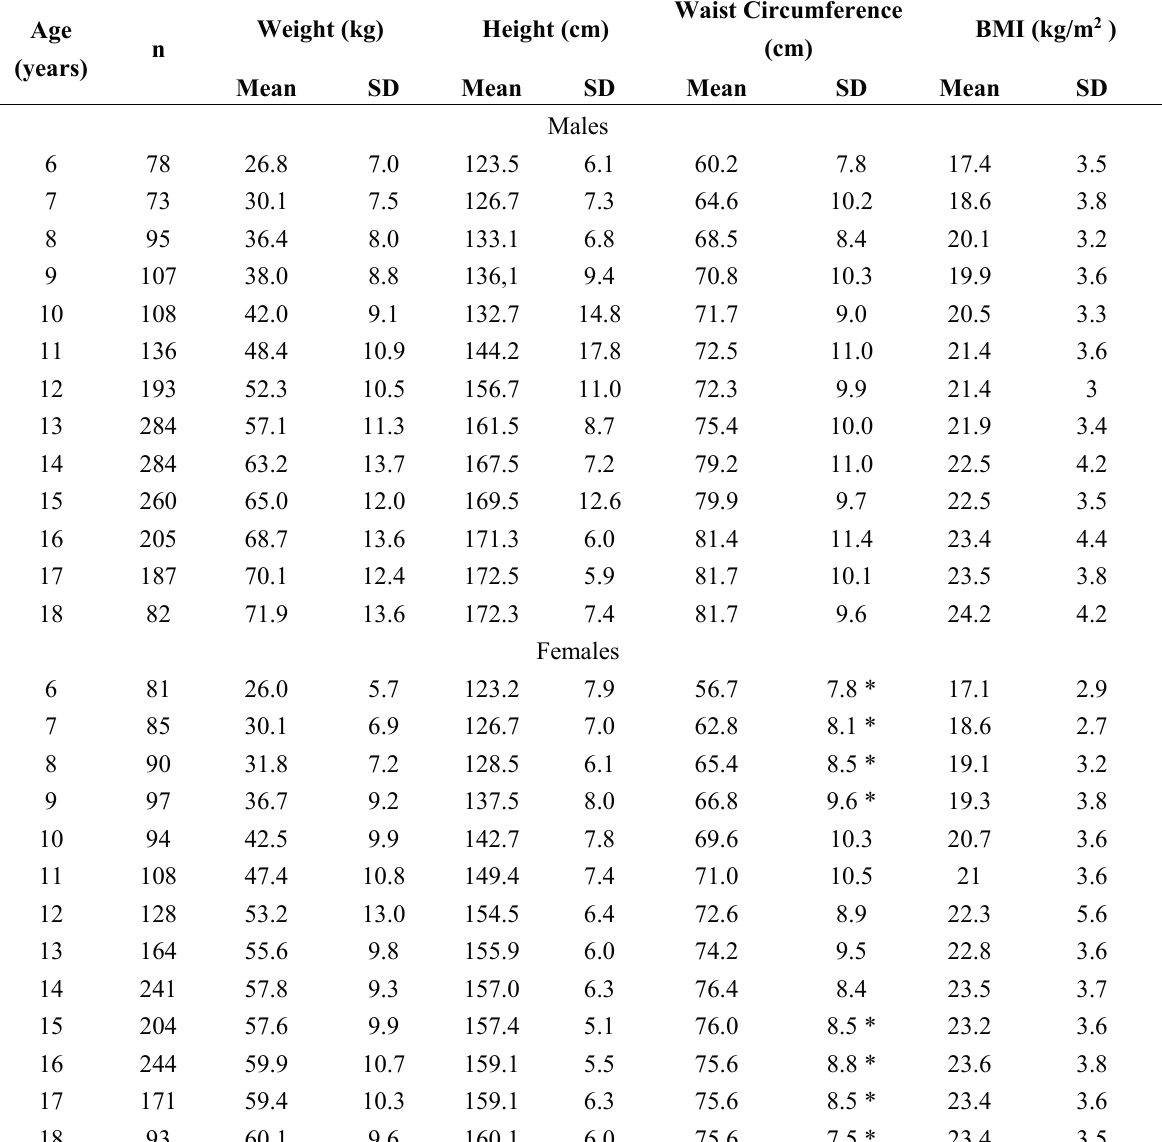
Table 1. Anthropometric characteristics of children and adolescents ages 6 to 18 years from the Maule Region,